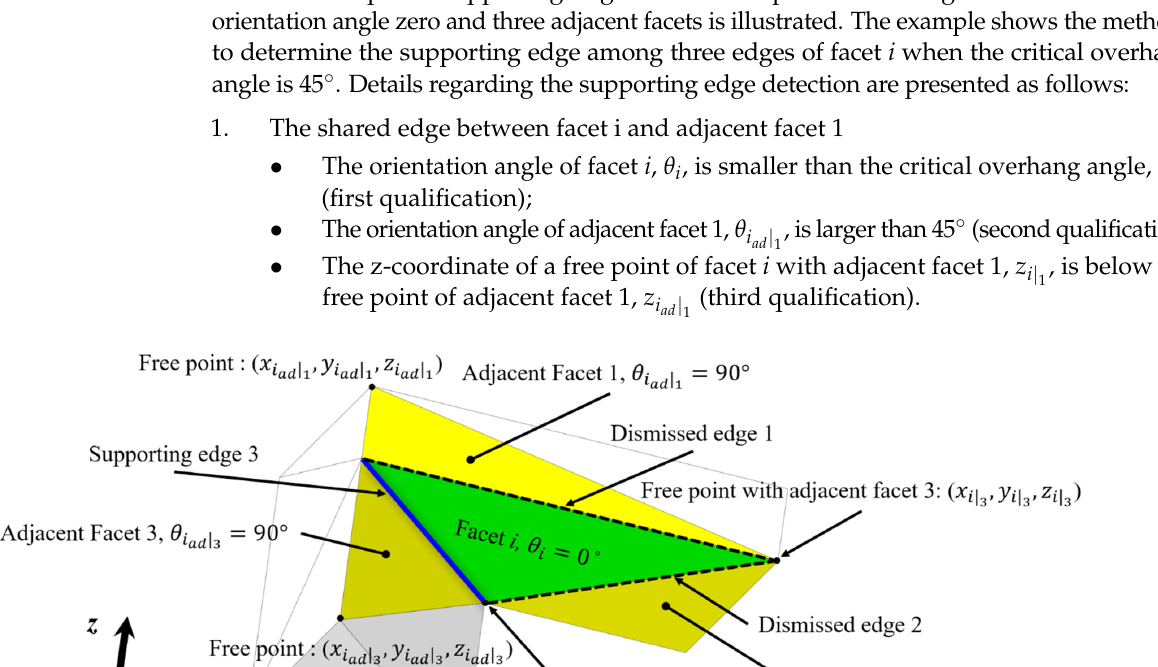
Figure 8. Initial step of collapse region search algorithm proposed herein.